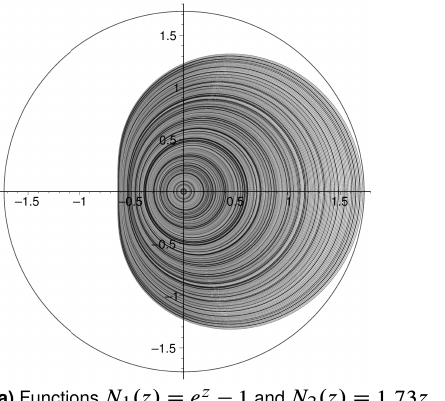
(a) Functions N 1 .z/ D e z (cid:0) 1 and N 2 .z/ D